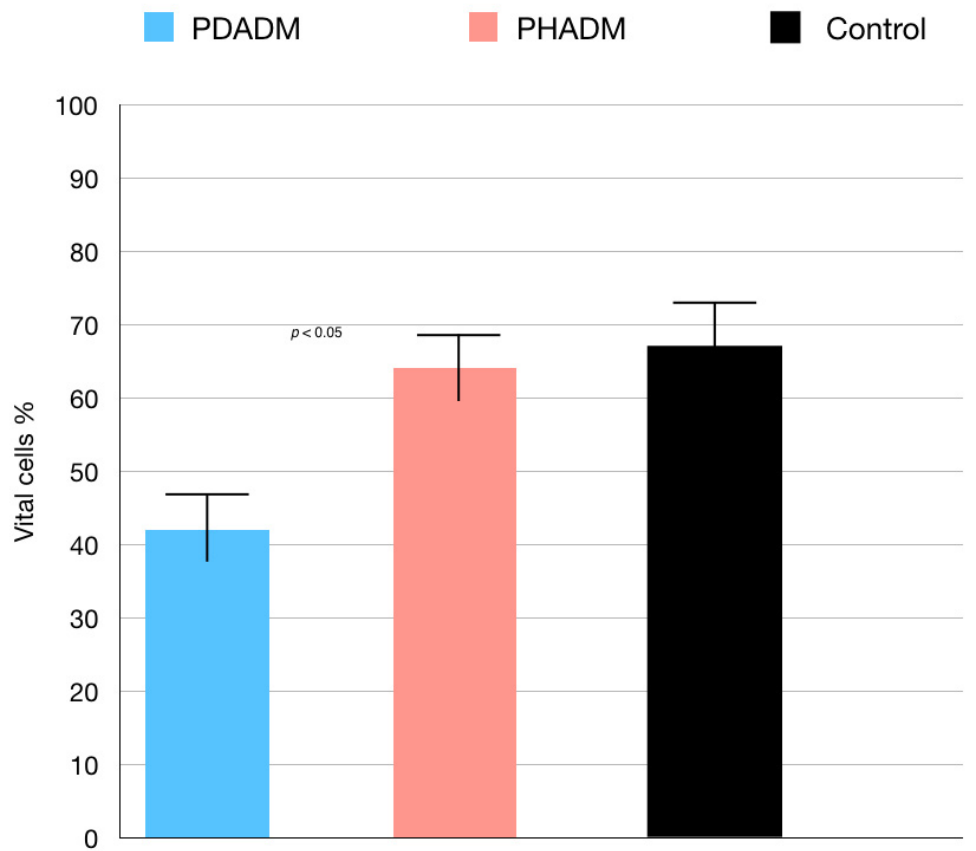
Figure 2. Results of the TEM of HPMSCs directly cultured on matrices after 7 days. Viable cell % = total number of viable cell per mL of aliquot/total number of cells per mL of aliquot × 100. Each column shows the results of experiments repeated three times. (One-way analysis of variance (ANOVA) with Tukey’s post-hoc test. Values of p < 0.05 were considered significant.)